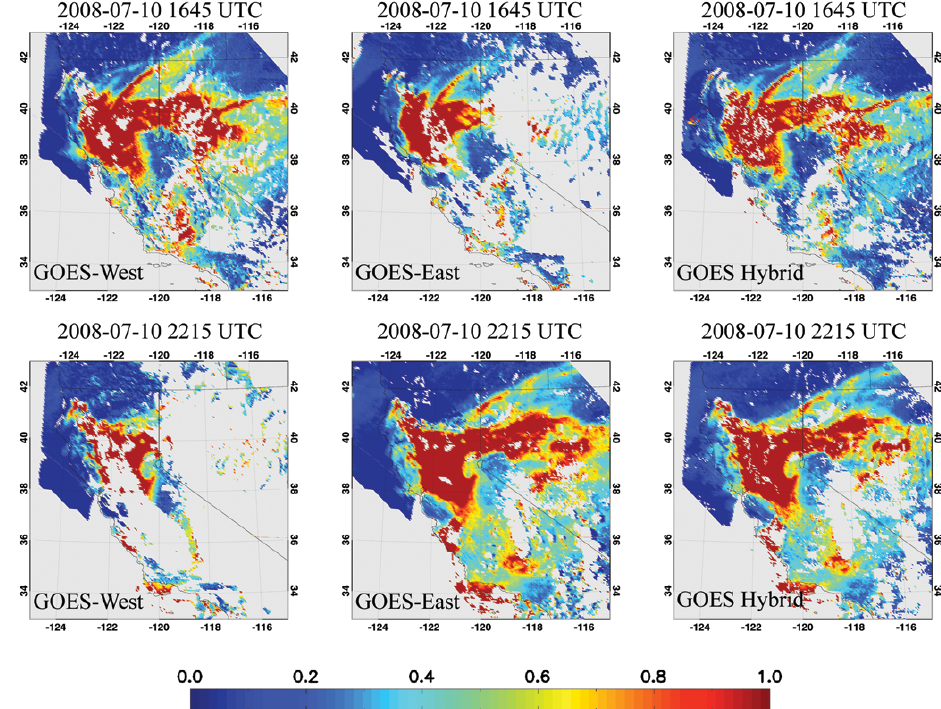
Fig. 12. Comparison of AOD retrievals from single satellite algorithms and from the hybrid algorithm for the California fire case on 10 July 2008 at two observation times: 16:45UTC and 22:15UTC. The retrievals from the combined algorithm are not plotted because they are the same as the single satellite retrievals with smaller scattering angles, i.e. GOES-West at 16:45 UTC and GOES-East at 22:15UTC.